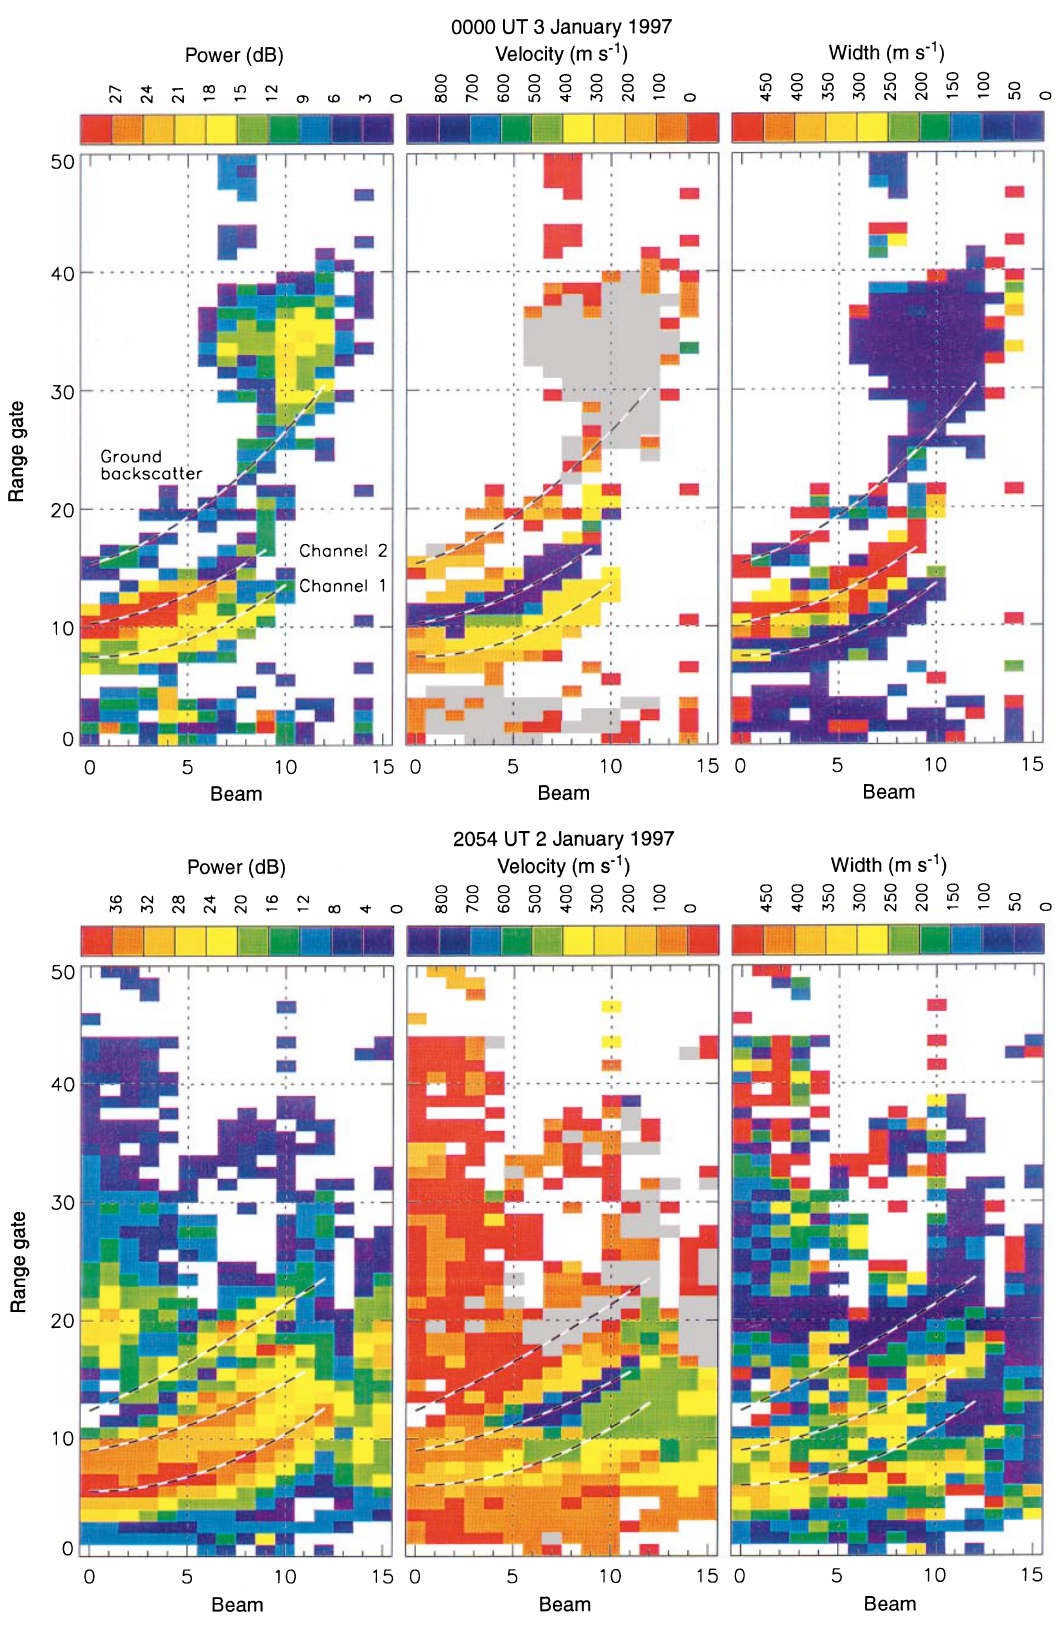
Fig. 2. The backscatter power, line-of-sight velocity and spectral width in the CUTLASS Iceland radar field of view at 0000 UT, 3 January 1997 and 2054 UT, 2 January